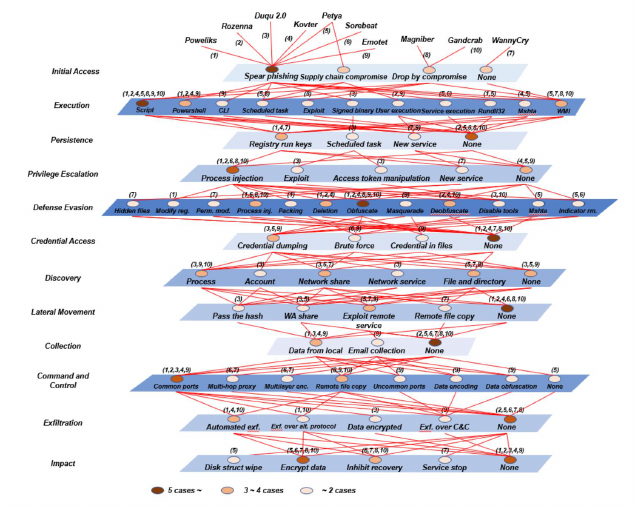
Figure 4. Attack techniques of a fileless cyber attack